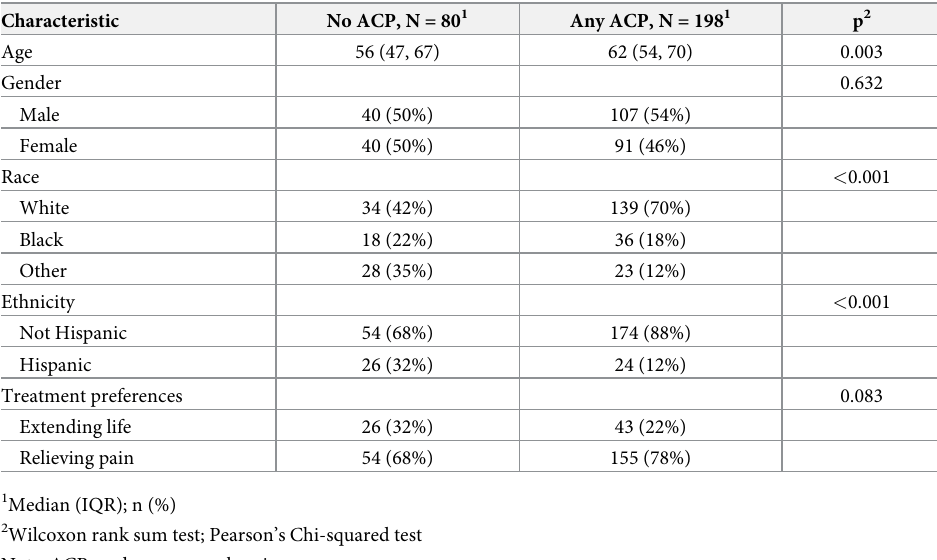
Table 1. Demographic characteristics and treatment preferences of unweighted sample (N =